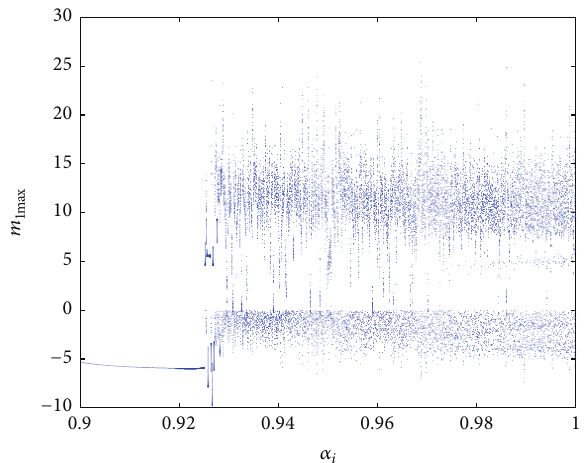
Figure 2: Bifurcation diagram of system (5) with 𝛼 1 = 𝛼 2 = 𝛼 3 = 𝛼 ∈ [0.9,1] .